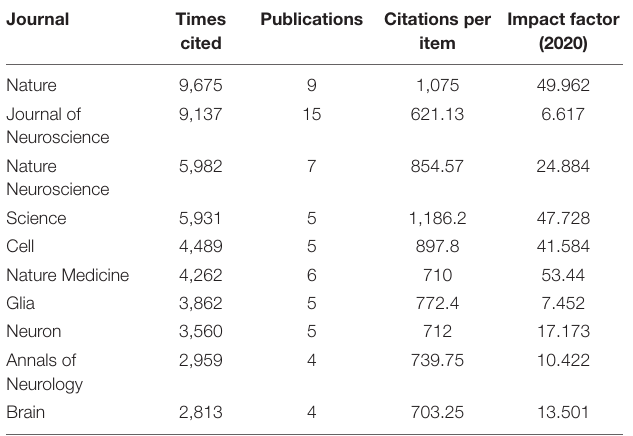
Frontiers in Aging Neuroscience |